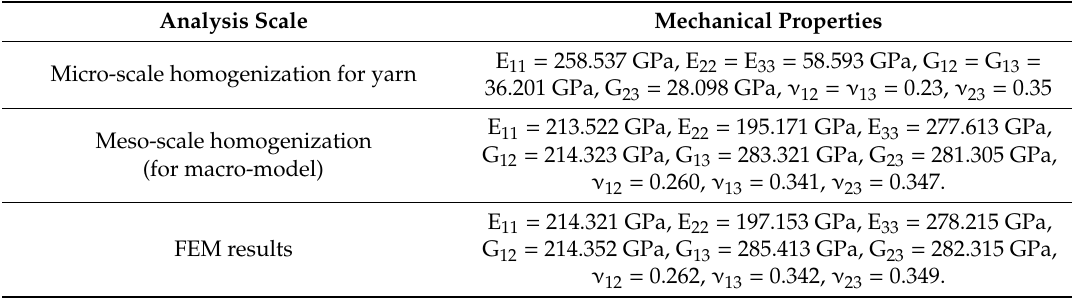
Table 5. Calculated material Properties for 3D four-directional braided ceramic matrix composites (CMCs) (silicon carbide / T300 carbon